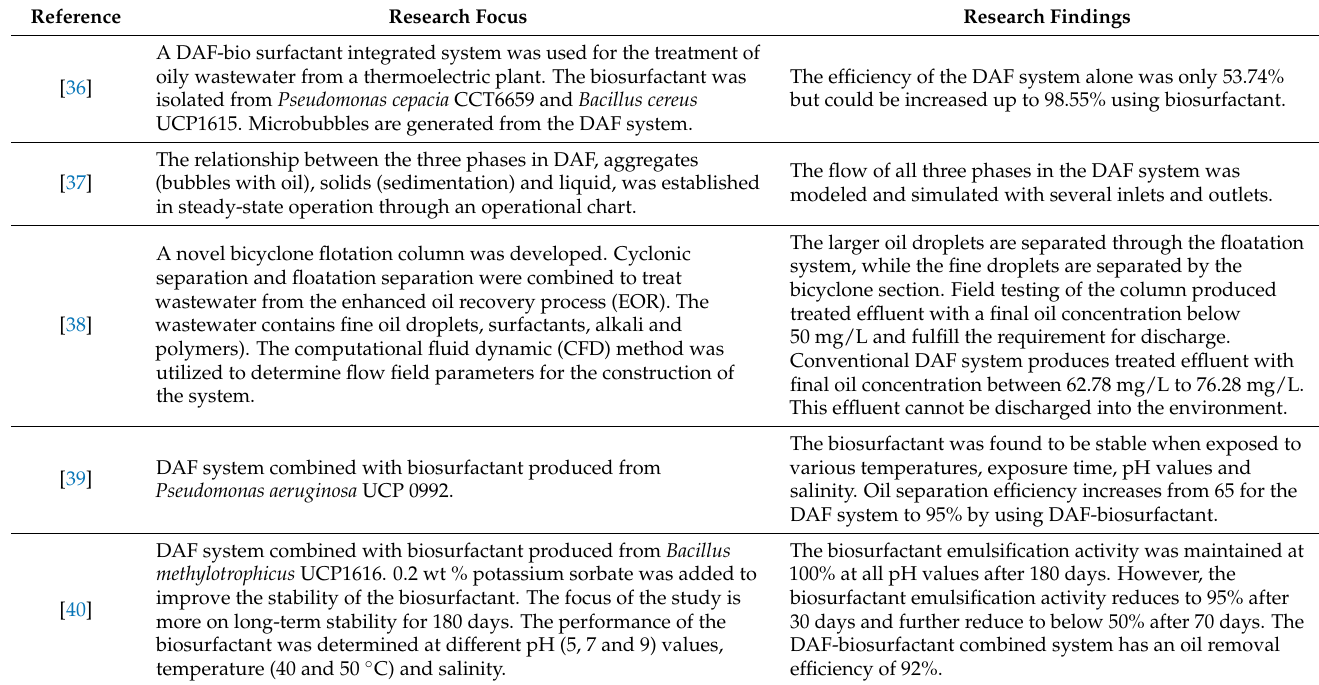
Table 2. The recent improvement of physical oily wastewater cleaning methods from 2018 to the present.